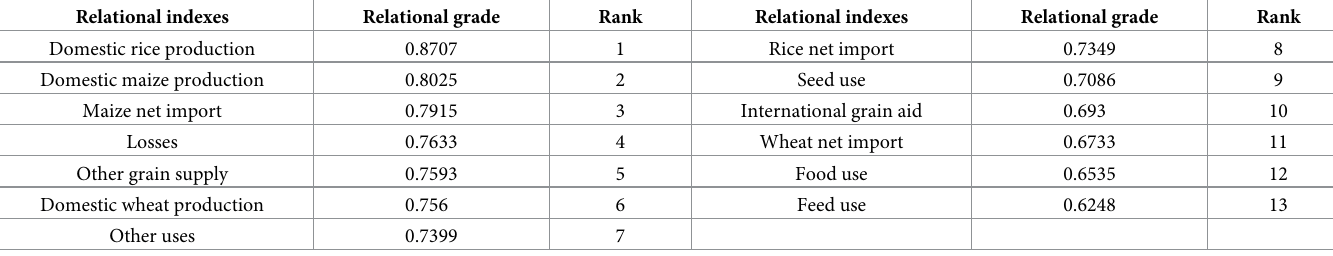
Table 3. Grey relational analysis results of grain supply-demand balance in